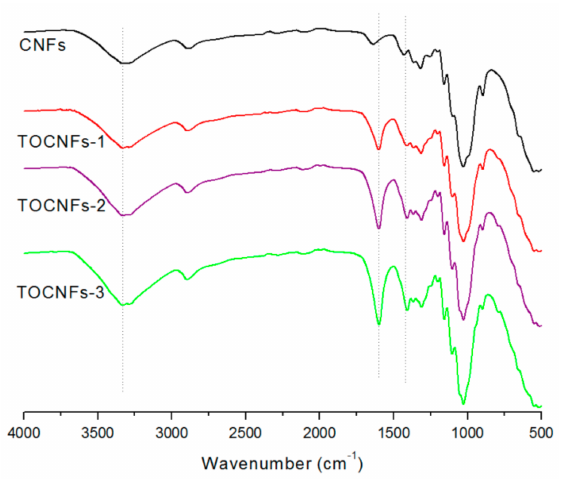
Figure 2. FT-IR spectra of CNFs and TEMPO-oxidized CNFs of different carboxylate contents.